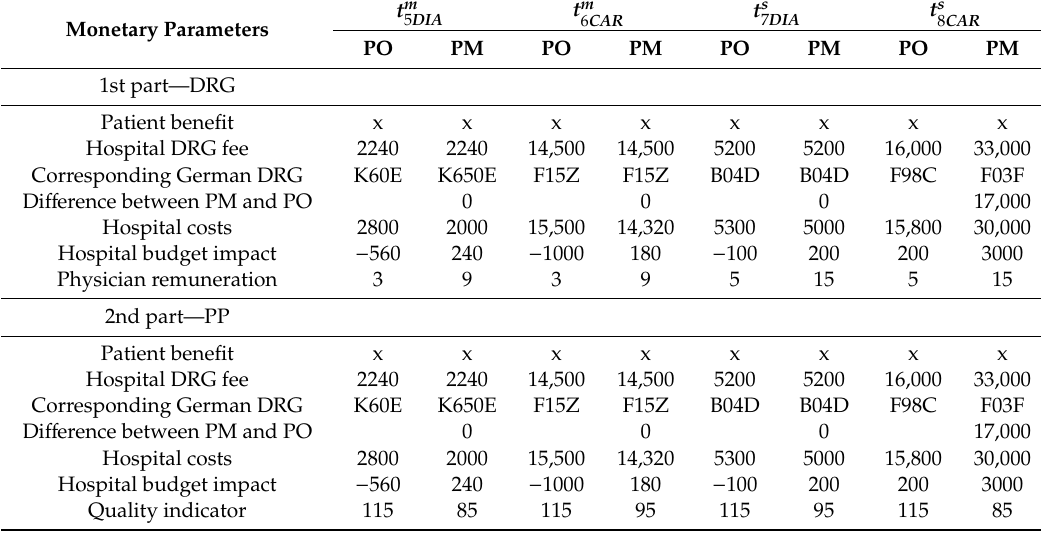
Table A2. Monetary Parameters for Hospital Physicians—Treatment Cases 5–8.